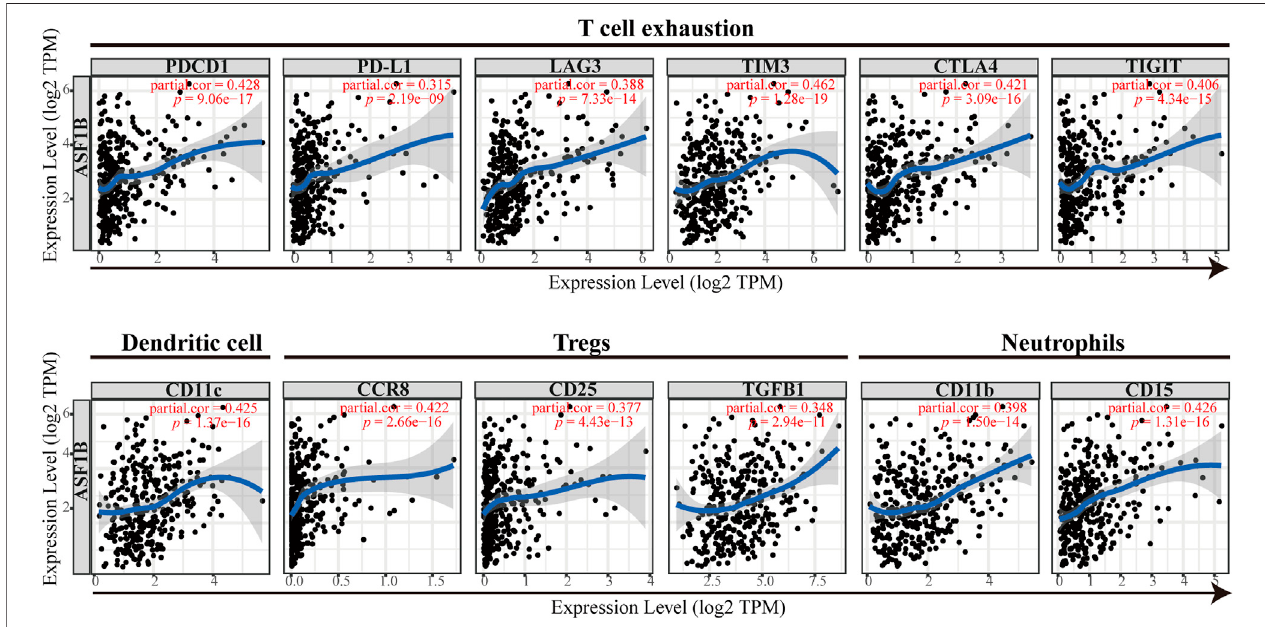
FIGURE 9 | The correlation between the immune marker sets of immune cells and ASF1B expression in